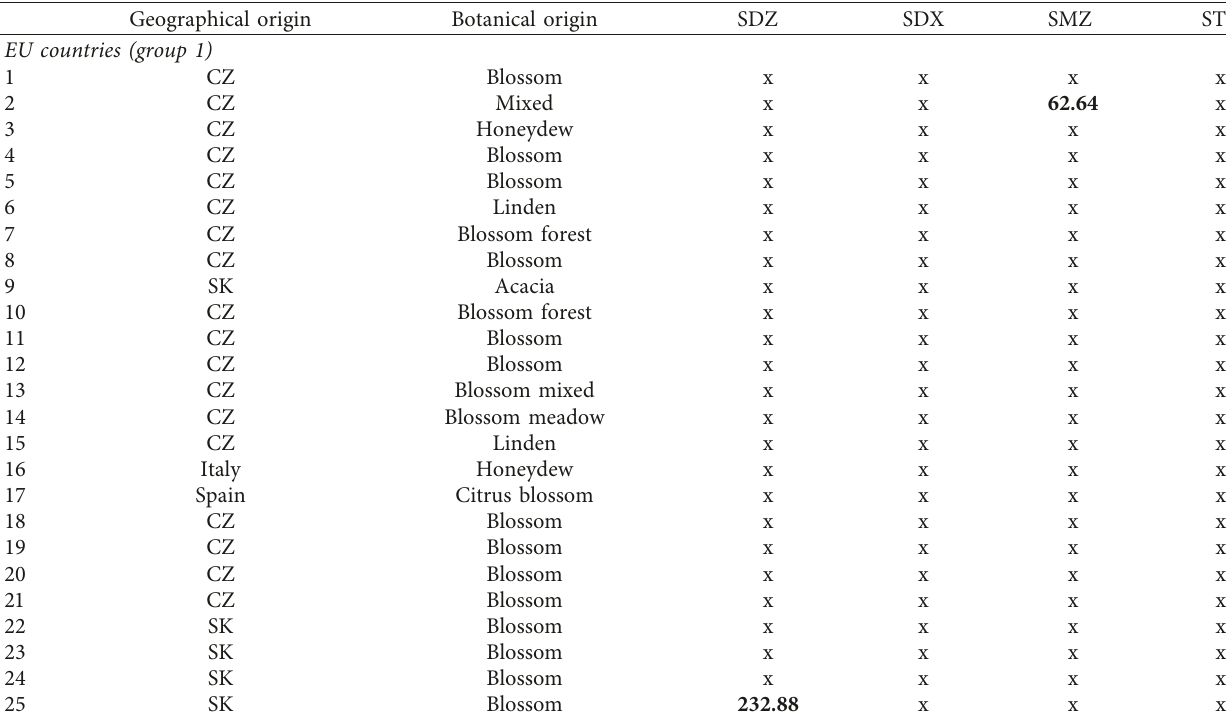
Table 3: Results of monitoring study: determination of SAs in honeys from European Union (EU) countries ( n � 25), from EU and non-EU countries ( n � 20) and from non-EU countries ( n � 5) in the Czech market; in units ( µ g/kg). Geographical origin Botanical origin